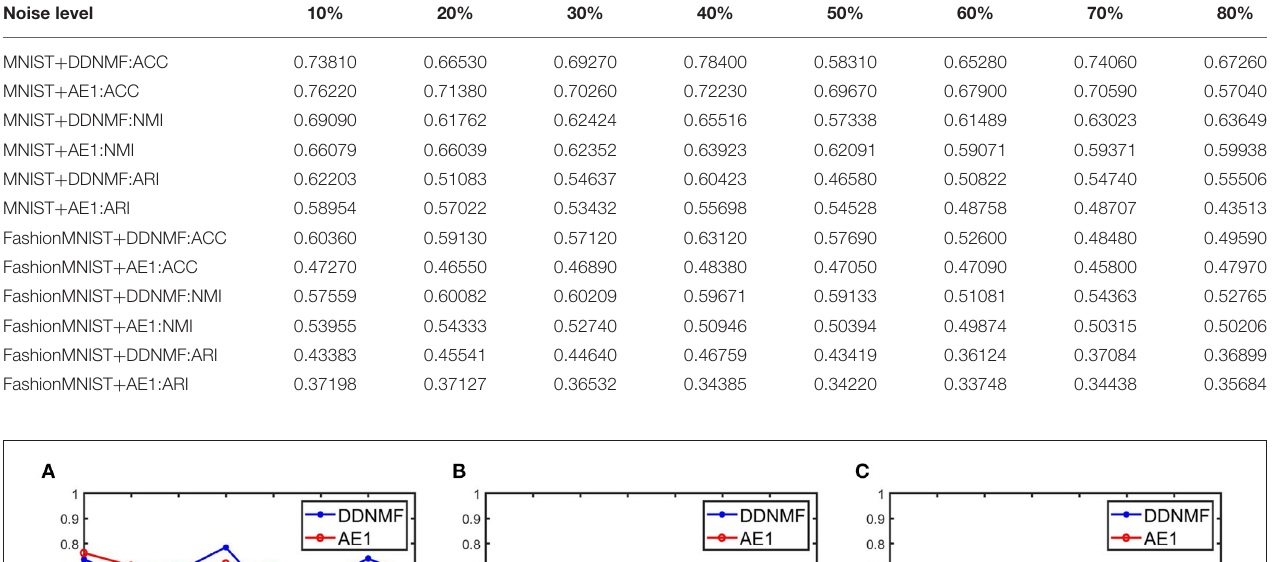
TABLE 3 | The results of DDNMF and AE1 on different noise levels.